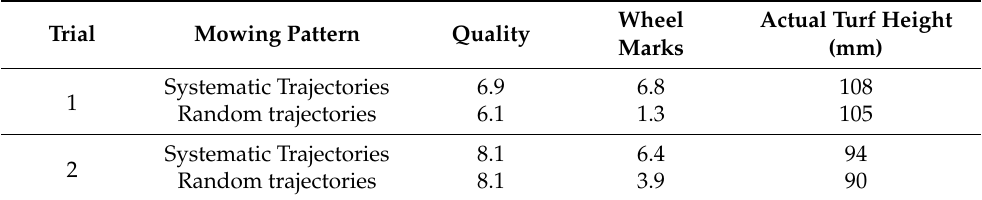
Table 4. Results for turf parameters evaluated during the two trials. Data were pooled over the 4 replications.